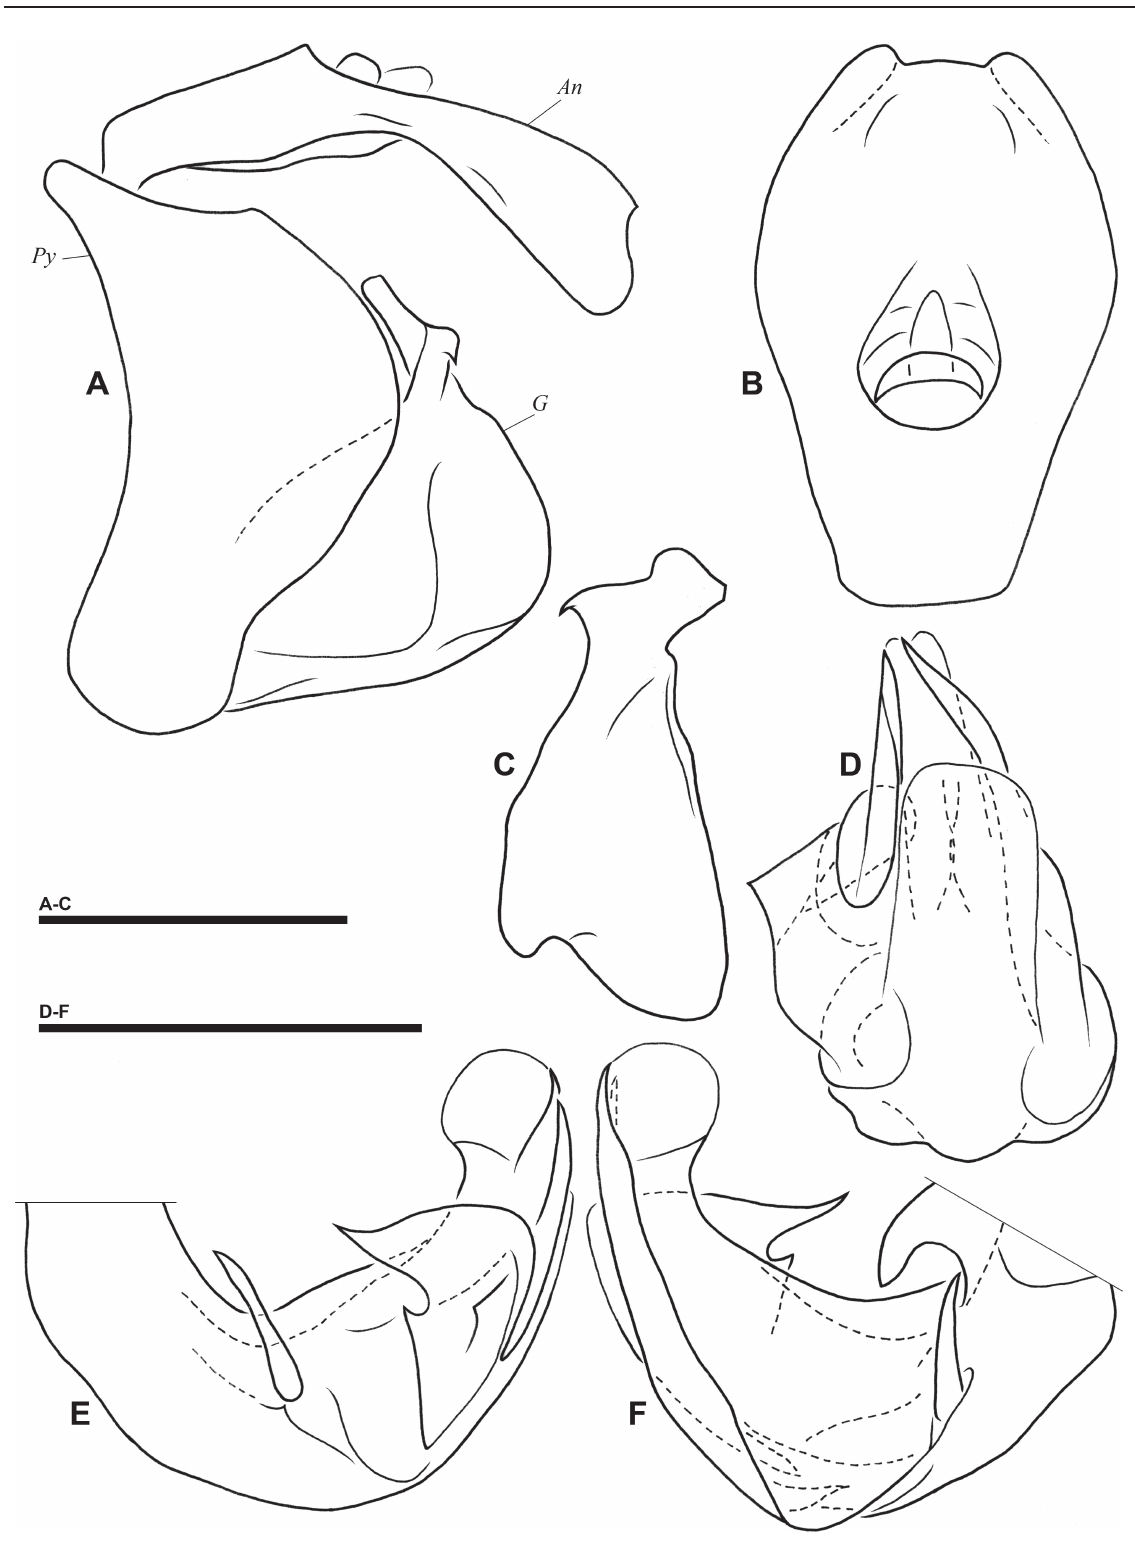
Fig. 6. Gergithus (Maculergithus) tamdao subgen. et sp. nov., holotype, male genitalia. A . Pygofer, anal tube and gonostyli, left lateral view. B . Anal tube, dorsal view. C . Left gonostylus, posterior view. D . Aedeagus, postero-ventral view. E . Aedeagus, left lateral view. F . Aedeagus, right lateral view. Abbreviations: An = anal tube; G = gonostyli; Py = pygofer. Scale bars: